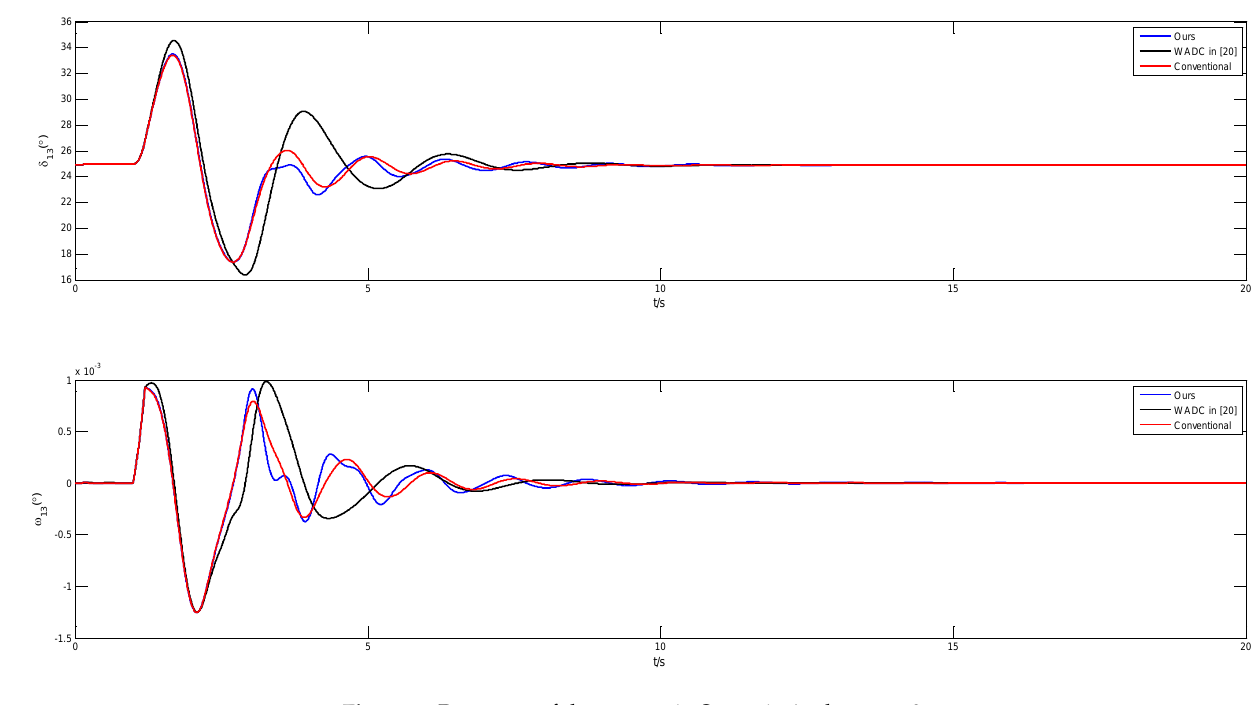
Figure 5. Response of the system in Scenario 1 when 𝜌 = 0 .